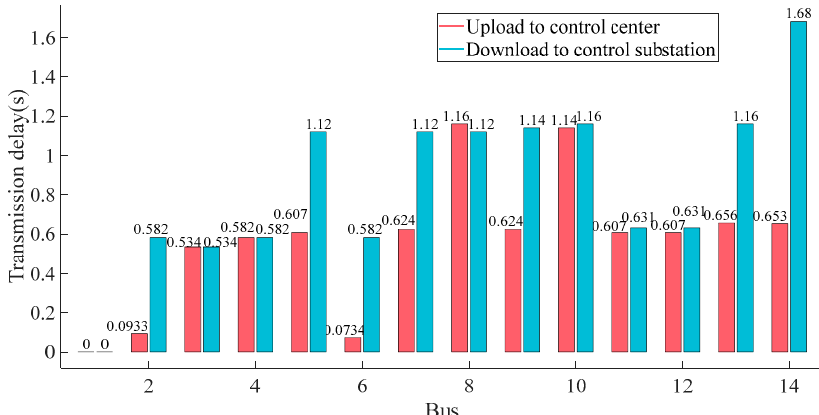
Figure 12. Communication transmission delay between client substations and the server substation.